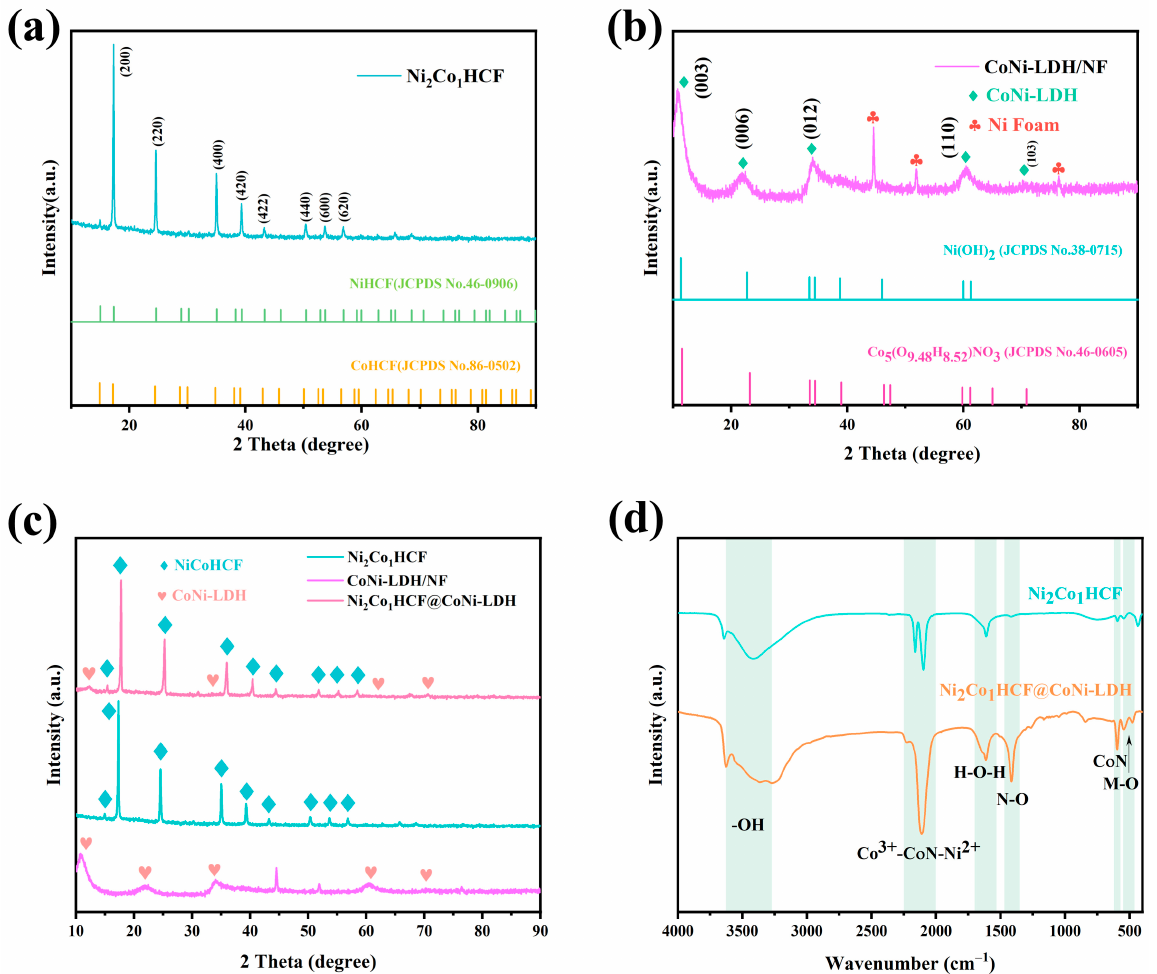
Figure 2. XRD patterns of ( a ) Ni 2 Co 1 HCF; ( b ) CoNi-LDH/NF; ( c ) Ni 2 Co 1 HCF@CoNi-LDH compo- sites. ( d ) Fourier transform infrared spectra of the Ni 2 Co 1 HCF and Ni 2 Co 1 HCF@CoNi-LDH compo- sites.